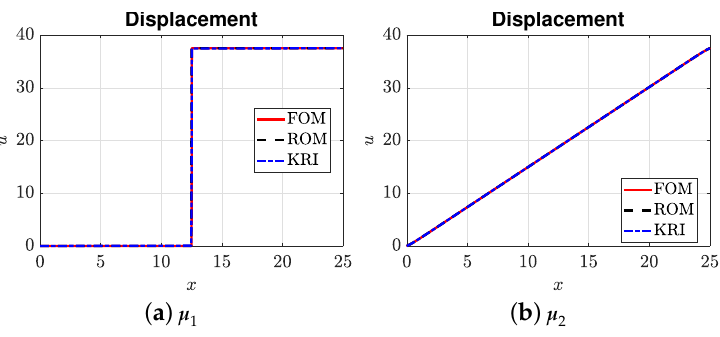
Figure 7. Displacement fields: for µ